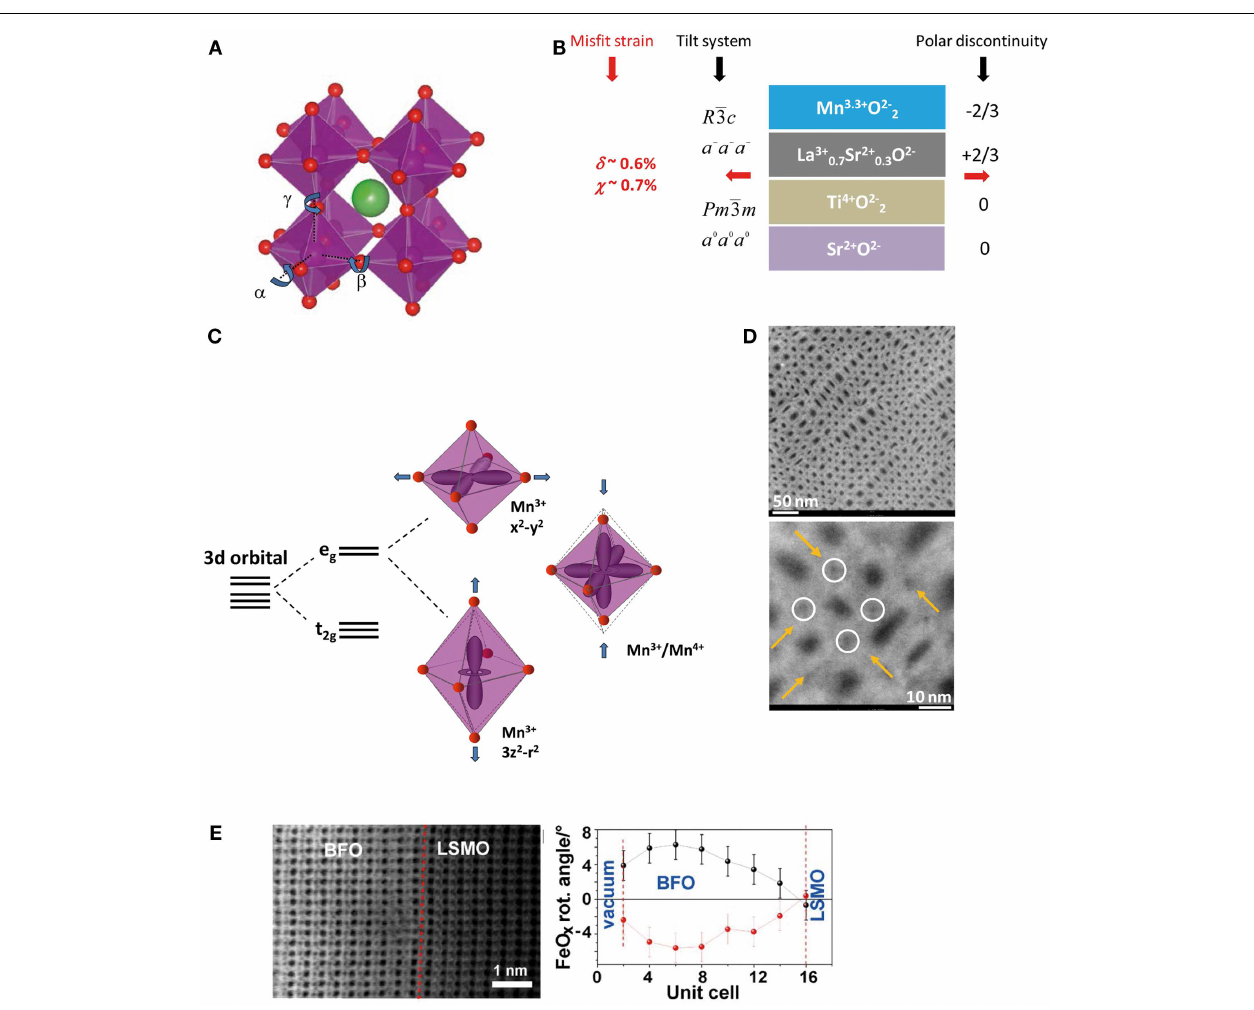
FIGURE 1 | (A) Pseudocubic (distorted) unit cell of an ABO 3 perovskite.The aristotype structure (space group Pm − 3 m ) consists of a three-dimensional framework of untilted ( α = β = γ = 0) regular BO 6 octahedra (O atoms are red circles) within the cavities of which lie the A cations (large green circles). Group-theoretical analysis yields 15 tilt systems (Howard and Stokes, 1998), which are commonly noted following the Glazer notation by the manner in which adjacent octahedra rotate one relative to each other along a particular axis of the undistorted cubic unit cell (Glazer, 1972); for instance, a − ( + ) indicates out-of-phase (in-phase) tilts and a 0 indicates no tilt.Thus the Pm-3m space group corresponds to the a 0 a 0 a 0 tilt system, while α (cid:54)= β (cid:54)= γ (cid:54)= 0° ( a − b − c − ) corresponds to the triclinic space group P − 1. (B) Different sources of dissimilarity between La 0.7 Sr 0.3 MnO 3 and SrTiO 3 .The rhombohedral structure of La 0.7 Sr 0.3 MnO 3 is forced to match the cubic SrTiO 3 substrate.The film is submitted to a tensile misfit strain besides a shear strain and a discontinuity between the a − a − a − and a 0 a 0 a 0 tilt systems. Moreover, as indicated in the right column, the (002) planes in La 0.7 Sr 0.3 MnO 3 have alternating net charges, while the (002) planes in SrTiO 3 are neutral, resulting in a polar discontinuity at the interface. (C) The six O 2 − anions surrounding the Mn 3 + /4 + cations in La 0.7 Sr 0.3 MnO 3 create an octahedral crystal-field potential that partly lifts the degeneracy of the 3d one-electron orbital levels. Orbitals pointing to the oxygen ions, e g , 3 z 2 − r 2 and x 2 − y 2 , are higher in energy than those pointing between them,